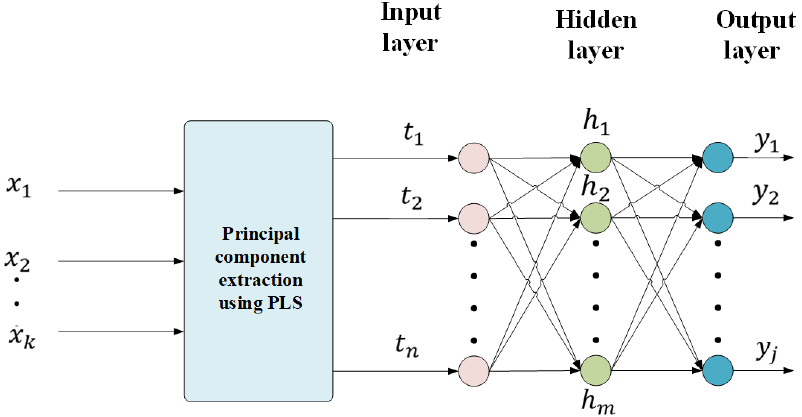
Figure 6. Structure diagram of the PLS-BPNN coupling model.